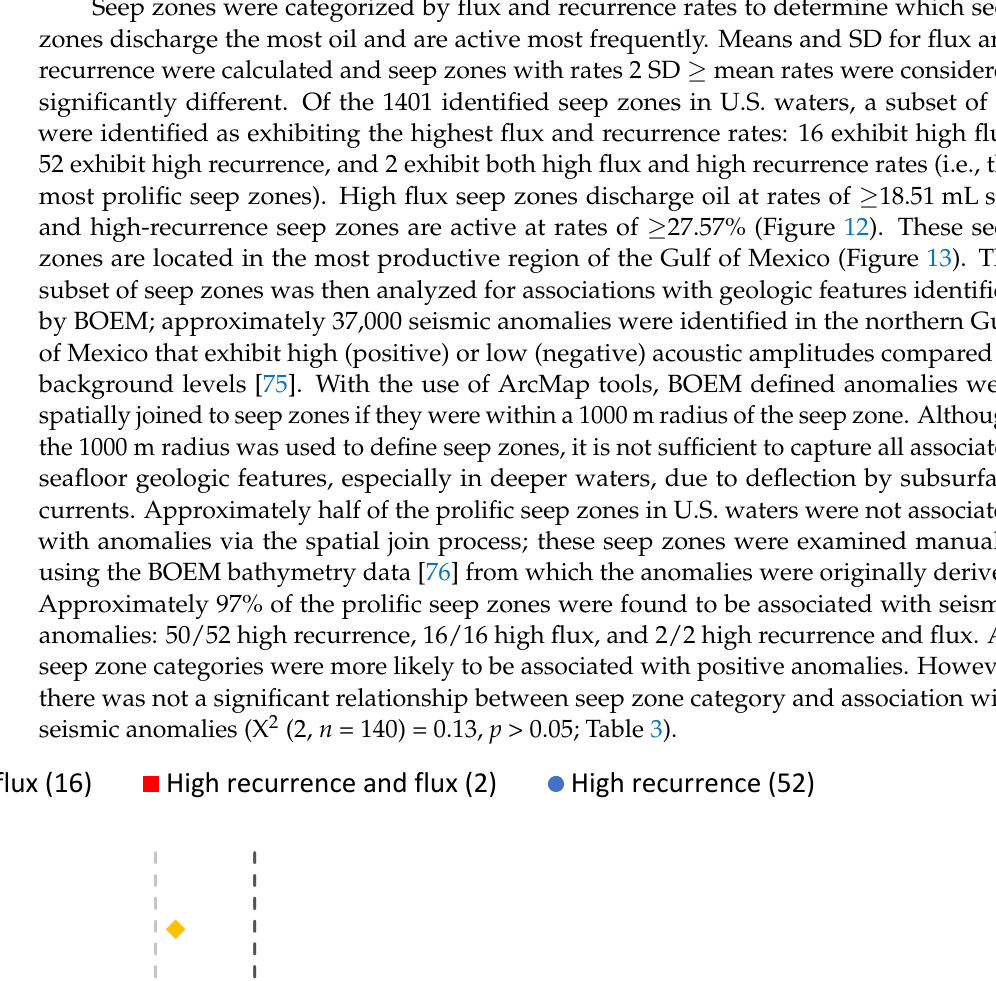
Figure 13. Locations of seep zones exhibiting rates of high flux, high recurrence, and both high flux and recurrence (i.e., 2 SD ≥ mean rate).